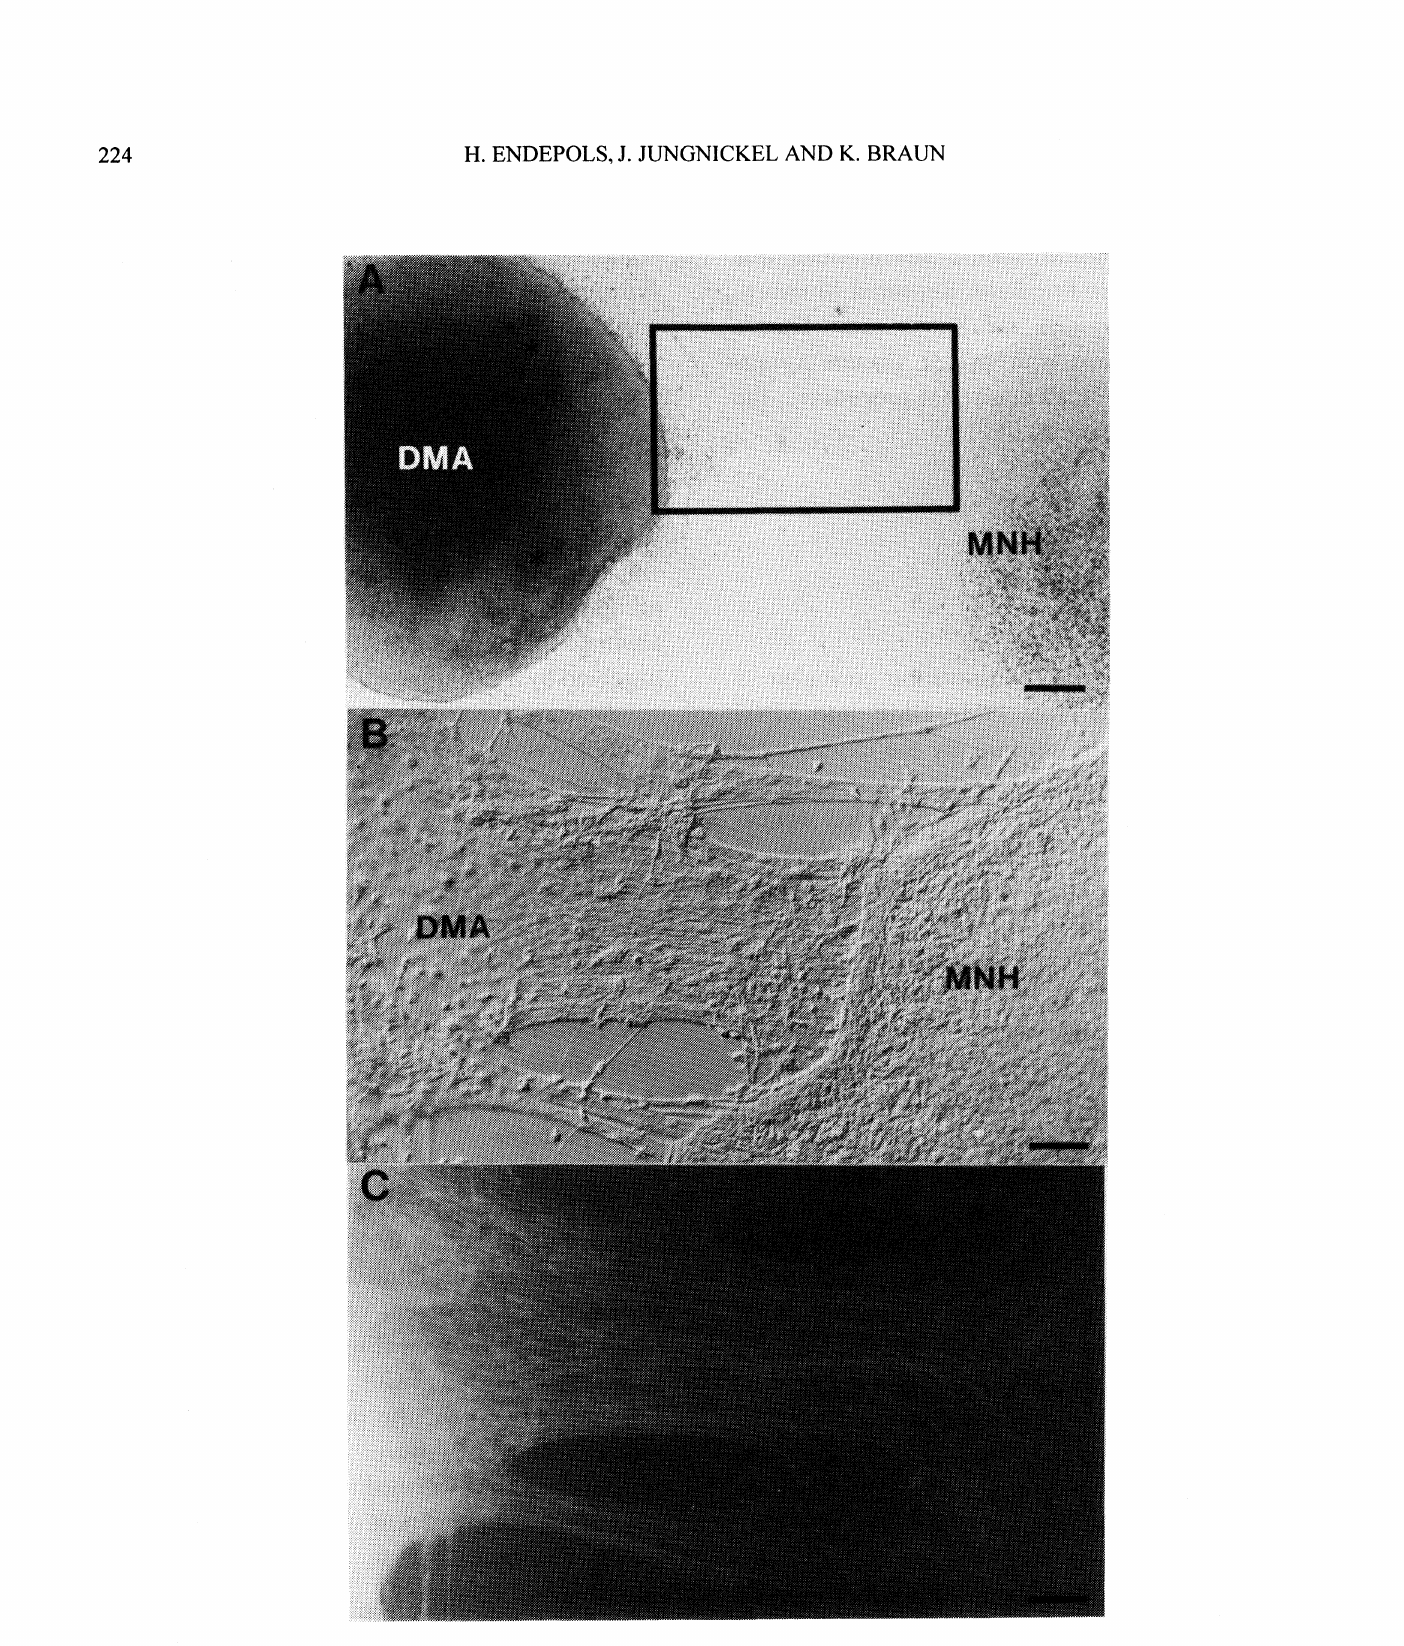
Fig. 2: Thalamus (DMA/DMP)-MNH coculture. A: Two DiI-crystals (asterisks) have been placed on the thalamus part of the eoculture (DMA). B: Detail of the contact zone between the two explants (frame in A). C: Same detail as in B, fluorescence illumination. Numerous axons of thalamic neurons are visible which project in bundles into MNH. Scale bar: A: 250 tm, B+C: 100